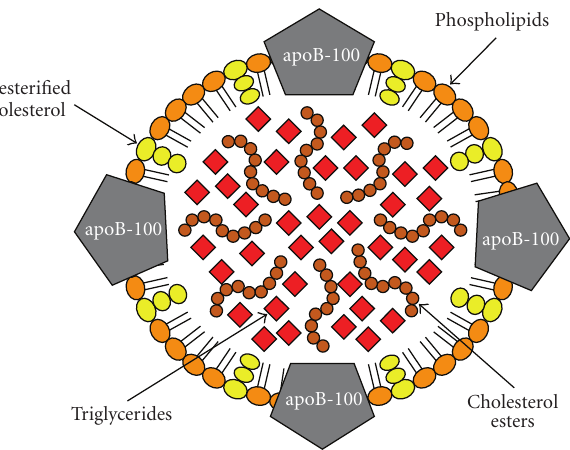
Figure 3: Schematic representation of the low-density lipoprotein particle (LDL). The LDL particle has a size of approximately 21– 24 nm and is the main transporter of unesterified cholesterol, cholesterol esters, and triglycerides in the blood. It contains an outer layer composed of phospholipids and unesterified cholesterol in which a single protein is embedded, the apolipoprotein B-100 (apoB-100). These components are more susceptible to oxidation by free radicals in the subendothelial space during inflammation. They are also targets for the recognition of the LDL by scavenger receptors, proteoglycans, and low-density lipoprotein receptor (LDLr). The core of the particle contains primarily cholesterol esters and triglycerides. In atherogenesis, a large number of IgM antibodies are created in response to oxidative stress-modified phospholipids, whereas IgG antibodies and T-cell clones are generated against